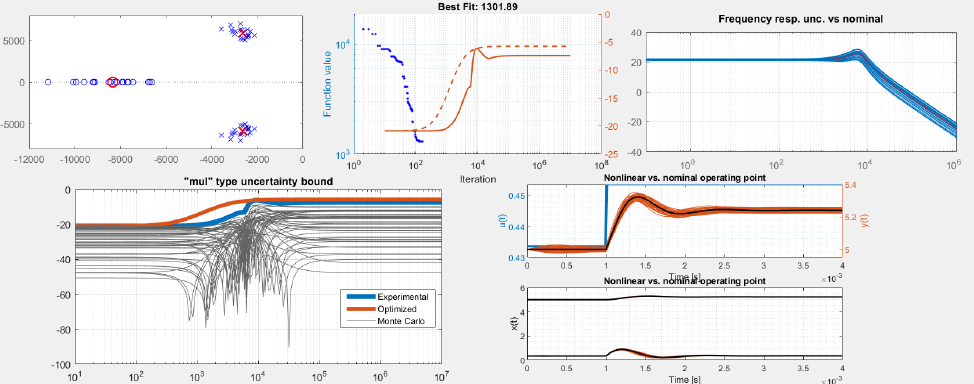
Figure 12. Buck multiplicative uncertainty set computation and open loop responses for the operating point with E = 12 [ V ] , R = 15 [ Ω ] , U R = 5 [ V ] : step and frequency response, pole-zero placement; the step response is simulated for nonlinear plants sampled using UncertainPlantFactory